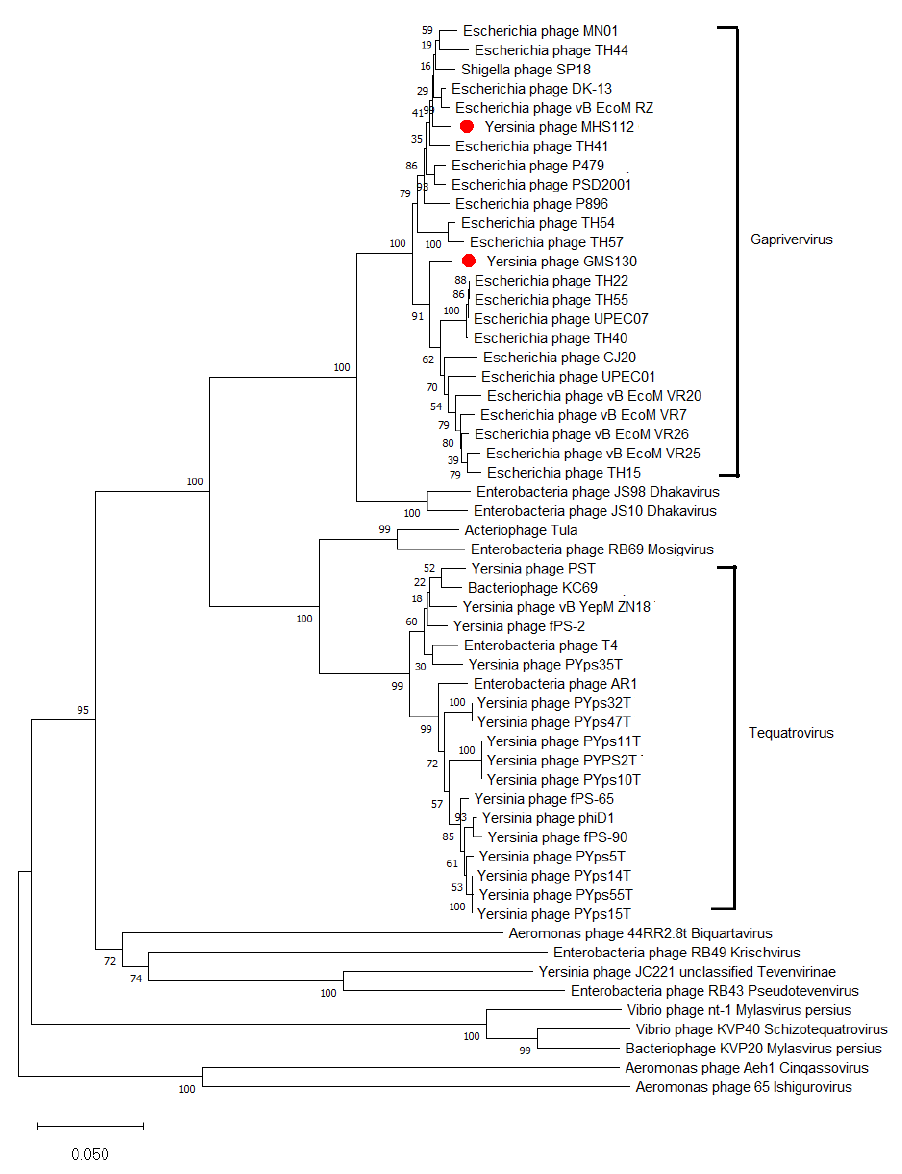
Figure 4. Unrooted phylogenetic tree of the structural gene gp23 in the genus Gaprivervirus bacterio- phages and representative T4-like phages infecting Yersinia .